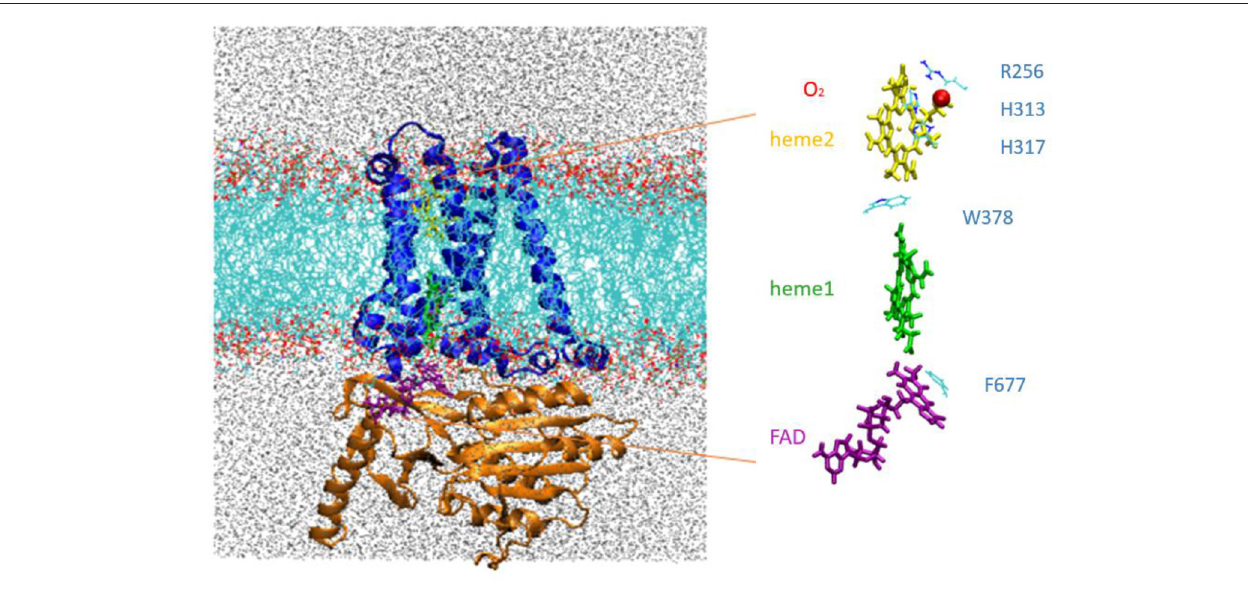
FIGURE 2 | Left, NOX5 catalytic core investigated in this study, composed of the transmembrane domain (in blue) and dehydrogenase domain (in orange) embedded in a lipid bilayer (in light blue and red). Water molecules are shown in gray. Right, insert shows the cofactor FAD (purple), Heme1 (green), Heme2 (yellow) and O2